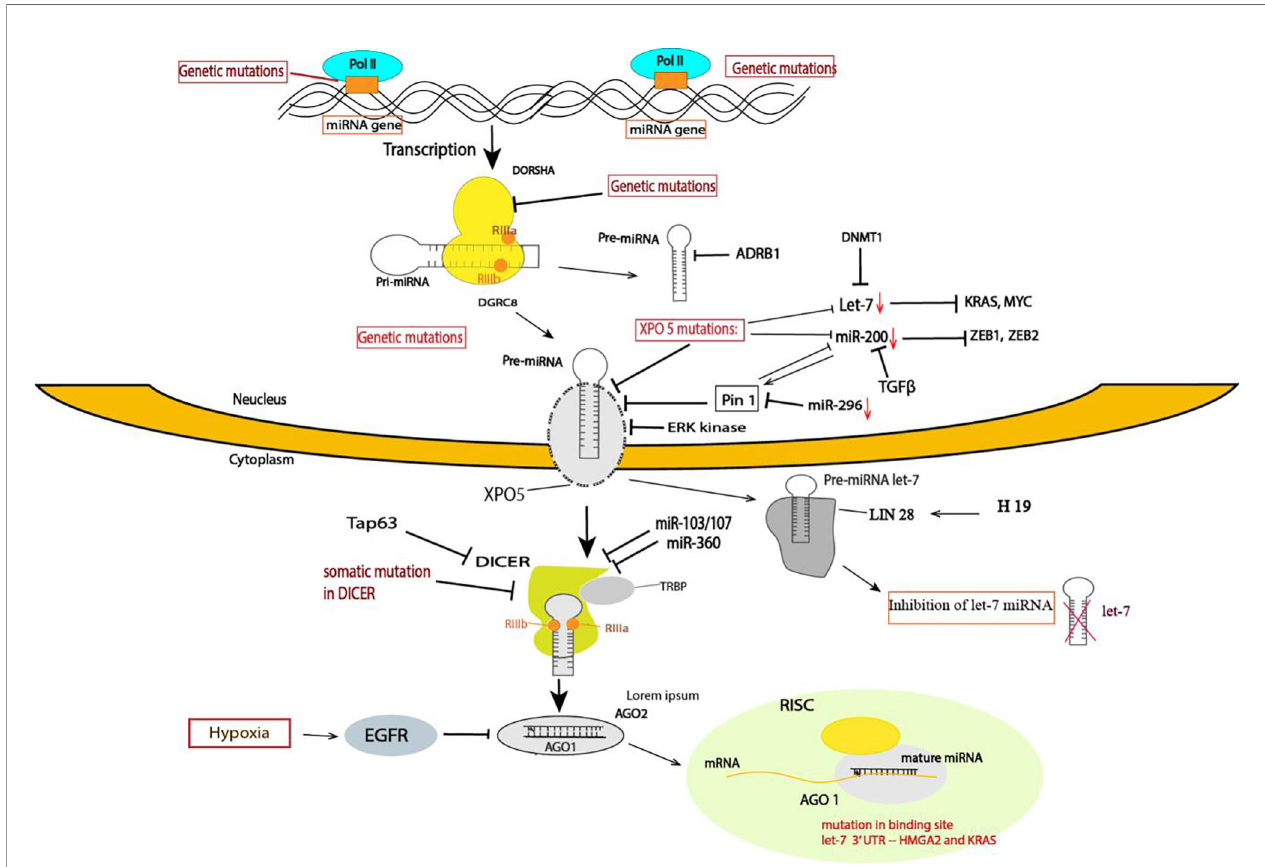
FIGURE 1 | Summary of the mechanism of TS miRNA regulation in cancer. The mechanism controlling TS miRNAs occurs at different steps in cancer, including transcriptional and posttranscriptional regulation. A variety of posttranscriptional regulation occurs in the miRNA biogenesis machinery, which affects the components of miRNA processing. miRNA processing of some TS miRNAs is regulated at multiple levels: at the gene level, through genetic mutations in the miRNA gene and in other components of miRNA processing, such Dorsha, Dicer, and TRBP, and in the binding site of miRNA targets and exportin-5. In XPO mutations, several TS miRNAs are downregulated in cancer, such as miR-200 and let-7. The miRNA transcripts are altered at transcription by several oncogenes, such Myc and TGFB, or by epigenetic modi fi cation. LIN 28 proteins speci fi cally block the processing of the pre-miRNA of Let-7. Several studies have highlighted that Dicer downregulation in cancer is caused by several factors, such as somatic mutations, Tap63, miR-360, and miR-103/107. EGFR suppresses the maturation of speci fi c TS miRNAs through phosphorylation of AGO2 and prevents the association of AGO2 with